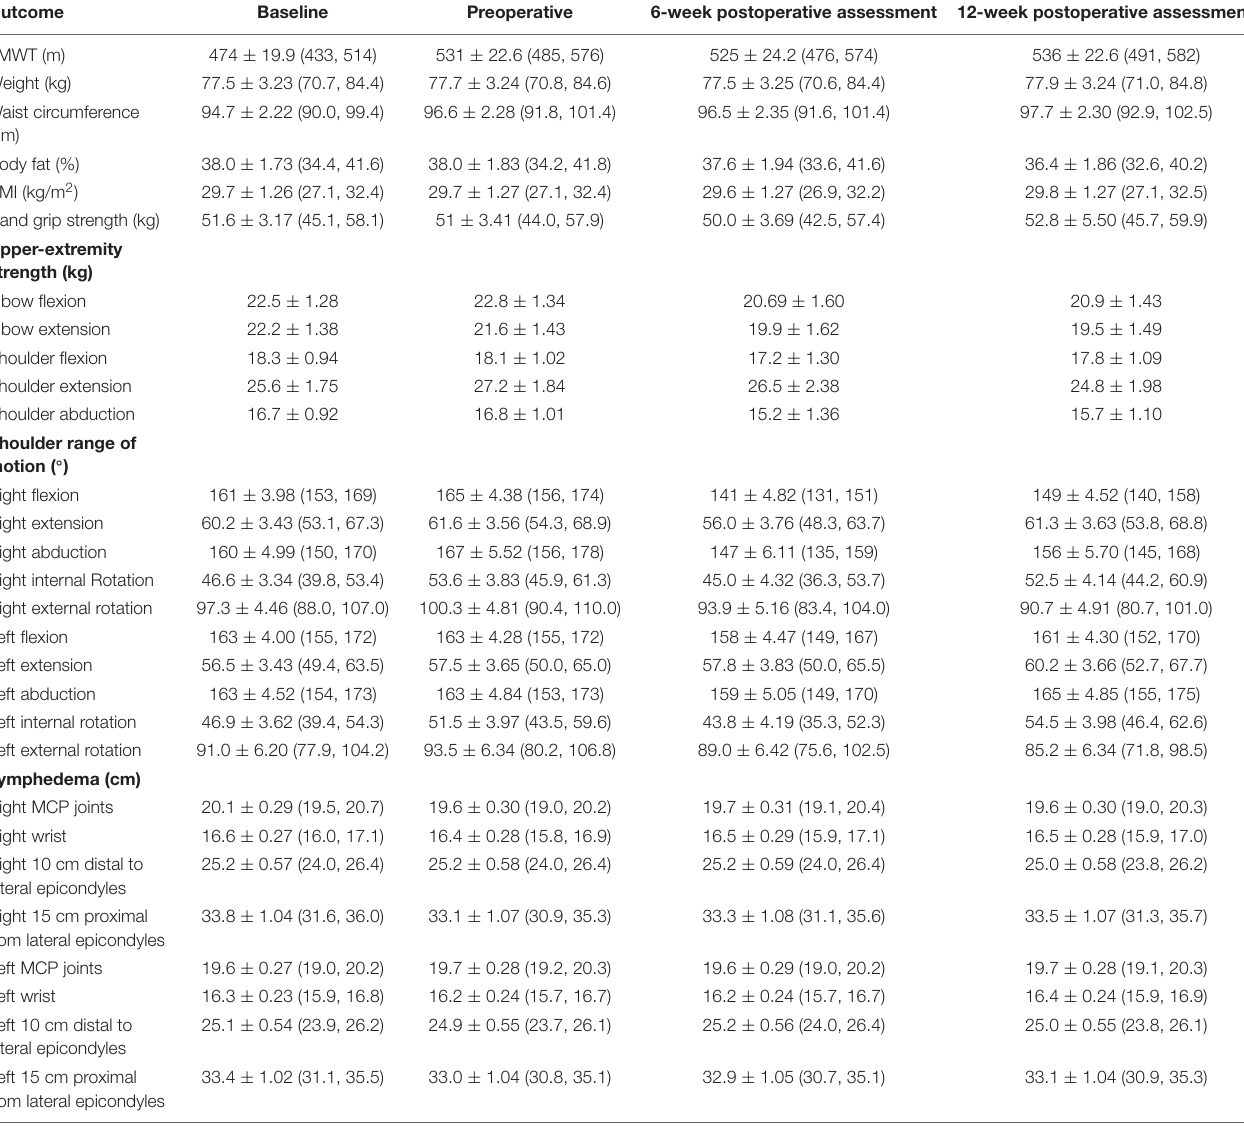
TABLE 2 | Mean estimates ± SE (95% CI) for objectively measured physical fitness outcomes ( n = 22). Outcome Baseline